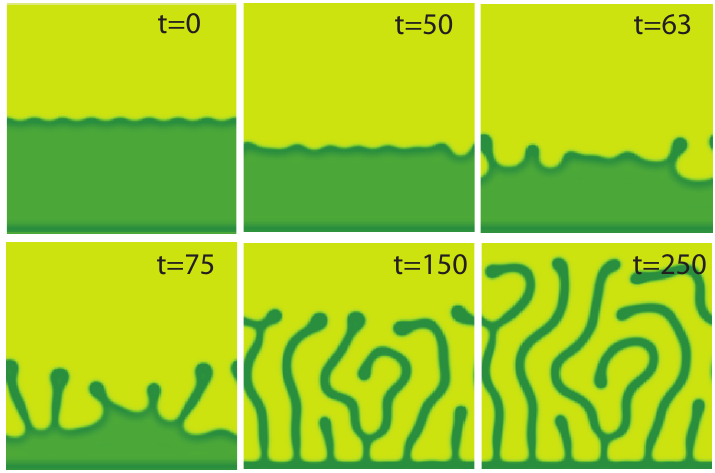
Figure 5. Snapshots of model solutions (see Appendix B) that demonstrate a linear front instability of a desertification front. Following a short phase in which the bare-soil domain (yellow) expands into the uniform-vegetation domain (green), transverse perturbations begin to grow and form vegetation fingers that grow back into the bare-soil domain. The time indicated in every snapshot is in units of years. From [85]